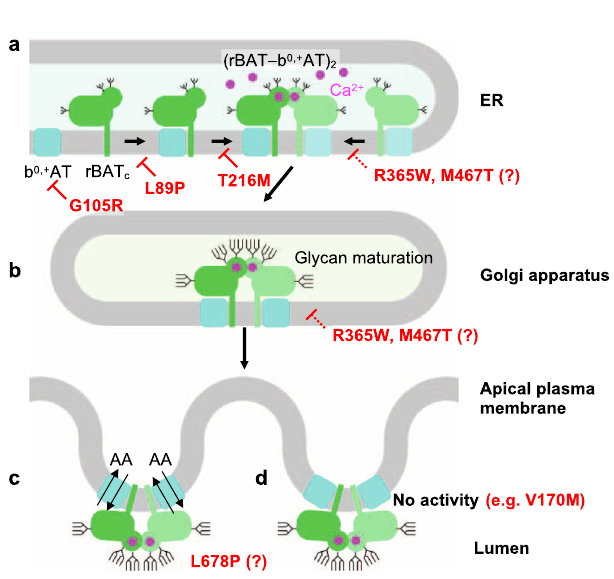
Fig. 10 A working model for b 0, + AT-rBAT biogenesis and its defects in cystinuria. a Model of super-dimer assembly in the ER. The initial step is the heterodimerization of b 0, + AT and core-glycosylated rBAT (denoted as rBAT c ). Since b 0, + AT is known to be required for oxidative folding and N-glycan maturation of rBAT 12 , defects in the b 0, + AT expression itself (e.g., b 0, + AT G105R) or the b 0, + AT – rBAT interaction (e.g., rBAT L89P) would interfere with the initial assembly process and thus prevent glycan maturation. In the latter step, two molecules of b 0, + AT – rBAT assemble to form a super-dimer, which requires Ca 2 + binding. Mutations that prevent super-dimerization, such as rBAT T216M and the Ca 2 + -binding site mutants, abolish this step. Incomplete complexes cannot pass the ER quality control. It is noted that rBAT R365W and M467T can form super- dimers to some extent but are probably less stable than the wild-type, due to their positions in the subdomain interfaces. b In the Golgi apparatus, the super-dimeric b 0, + AT – rBAT undergoes full glycan maturation (mature glycans are depicted by longer branches). As rBAT R365W and M467T can form super-dimers, they get partially maturated. c Upon correct maturation, super-dimeric b 0, + AT – rBAT will be traf fi cked to the apical membrane of epithelial cells. Microvilli consist of numerous membrane protrusions, consistent with the curved lipid bilayer of b 0, + AT – rBAT. d Non-type I mutations (e.g., b 0, + AT V170M) abolish transport